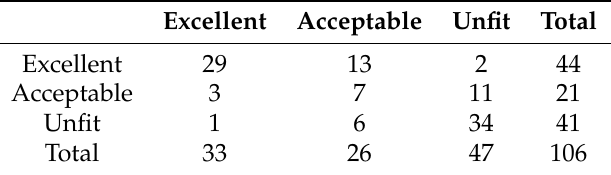
Table 1. Inter-rater agreement kappa statistic ( k ) to evaluate the agreement between two independent annotators. Here, k = 0.48, indicating moderate agreement where the number of observed agreements is 70 (66.04% of the